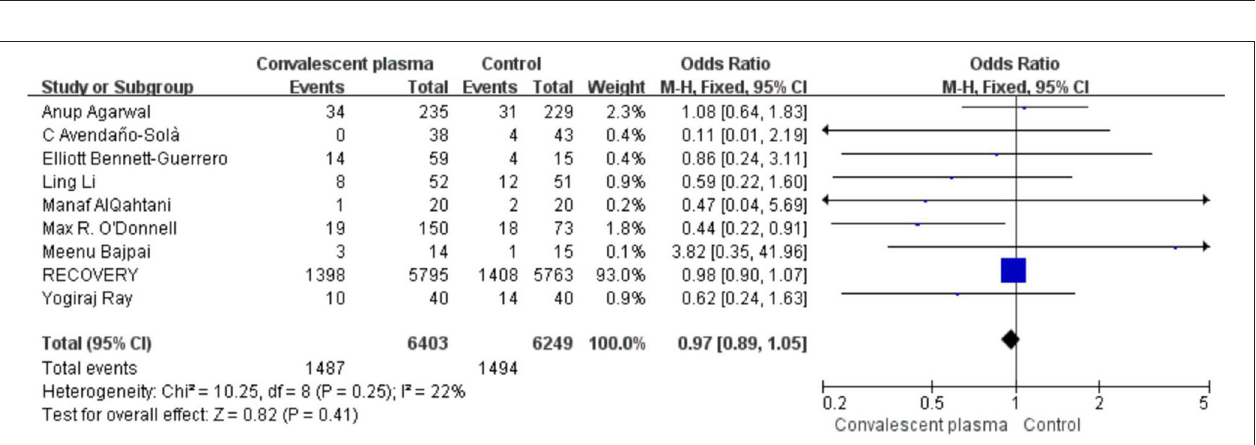
FIGURE 3 | Forest plot of pooled odds ratios (ORs) of mortality among patients treated with convalescent blood products and controls ( n = 16 studies). Weights are from fixed-effects analysis. CI, confidence interval.